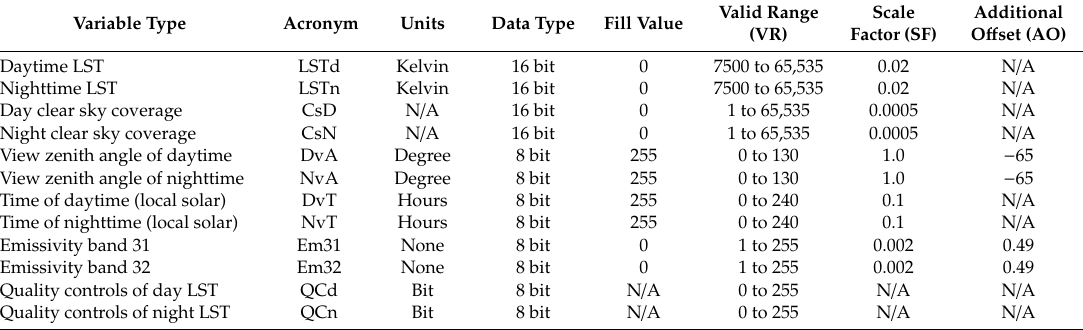
Table 1. Description of Moderate Resolution Imaging Spectroradiometer (MODIS) land surface temperature (LST) products used in this study (source: Land Processes Distributed Active Archive Center (LP DAAC),